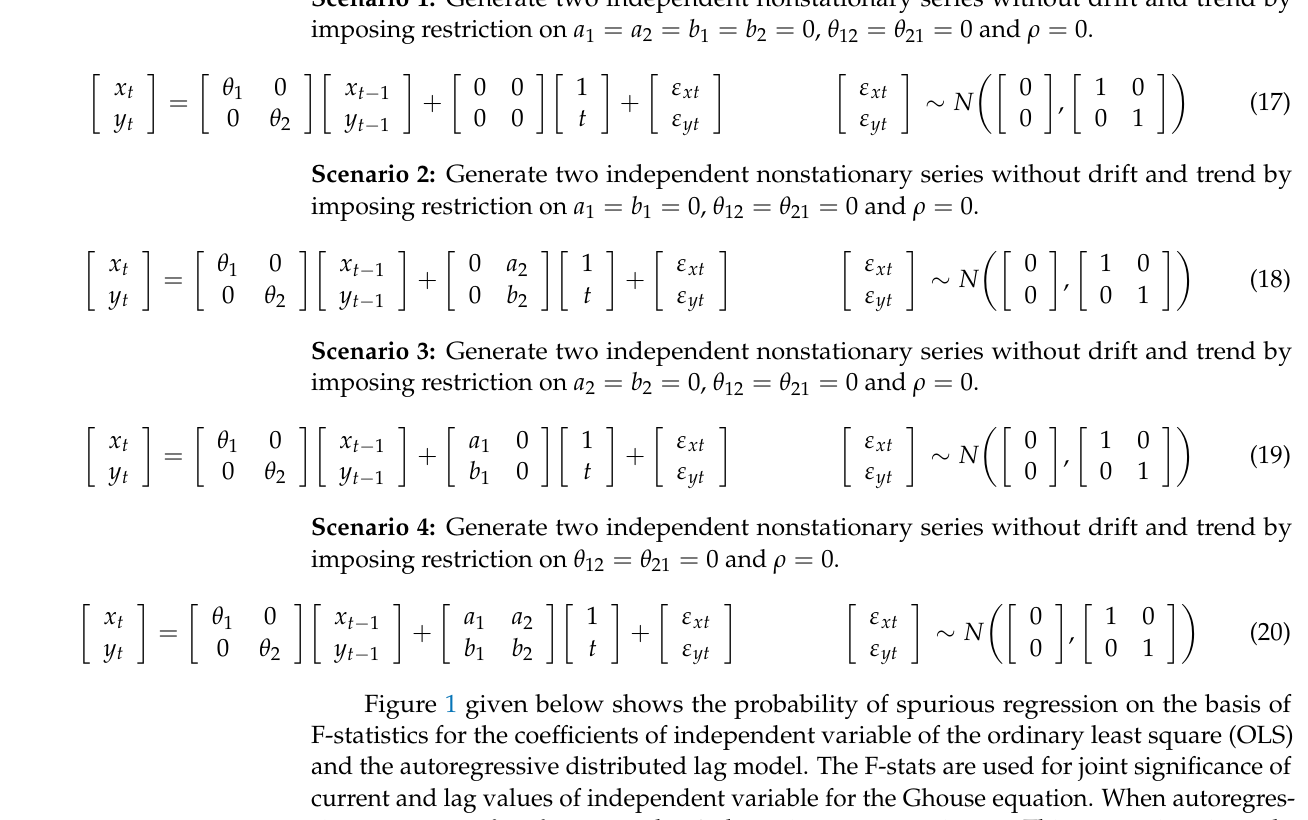
data-generating process given in Equation (6): Scenario 1: Generate two independent nonstationary series without drift and trend by imposing restriction on a 1 = a 2 = b 1 = b 2 = 0, θ 12 = θ 21 = 0 and ρ = 0.